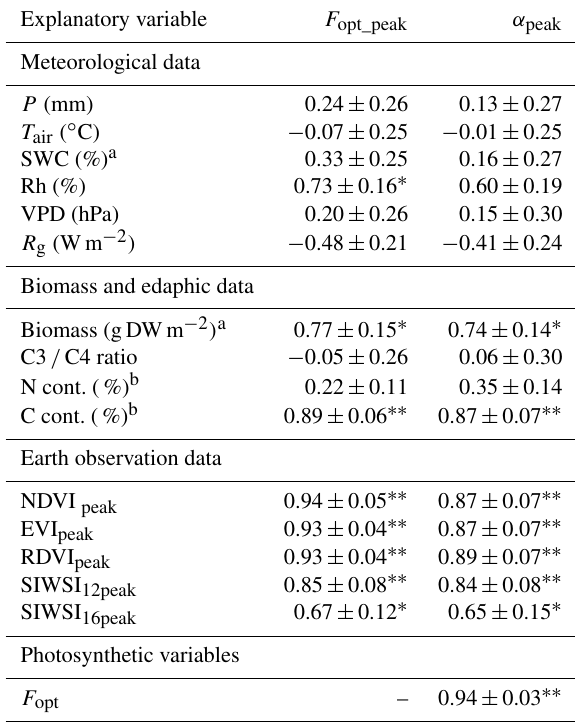
Table 5. Correlation matrix between annual peak values of photo- synthetic capacity ( F opt_peak ) and quantum efficiency ( α peak ) and measured environmental variables: annual rainfall ( P ); yearly av- erages of air temperature at 2m height ( T air ) , soil water content measured at 0.1m depth (SWC; % volumetric water content), rel- ative humidity (Rh), vapour pressure deficit (VPD) and incoming global radiation ( R g ) ; soil nitrogen (N) and carbon (C) contents; and annual peak values of the normalized difference vegetation index (NDVI peak ) , the enhanced vegetation index (EVI peak ) , the renor- malized difference vegetation index (RDVI peak ) , the shortwave in- frared water stress index based on MODIS NBAR bands 2 and 5 (SIWSI 12peak ) , and the SIWSI based on MODIS NBAR bands 2 and 6 (SIWSI 16peak ) . Sample size was 13 for all except the marked explanatory variables.